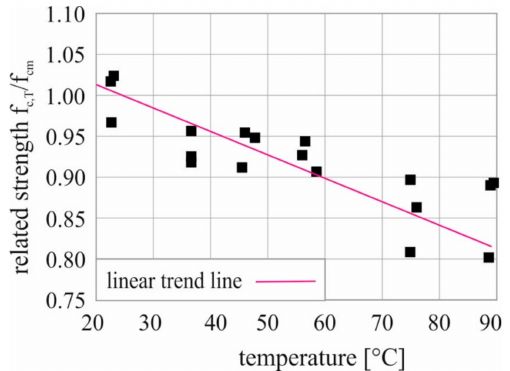
Figure 3. Related static compressive strength of UHPC at material temperatures between 20 and 90 ◦ C with linear trend line [22].